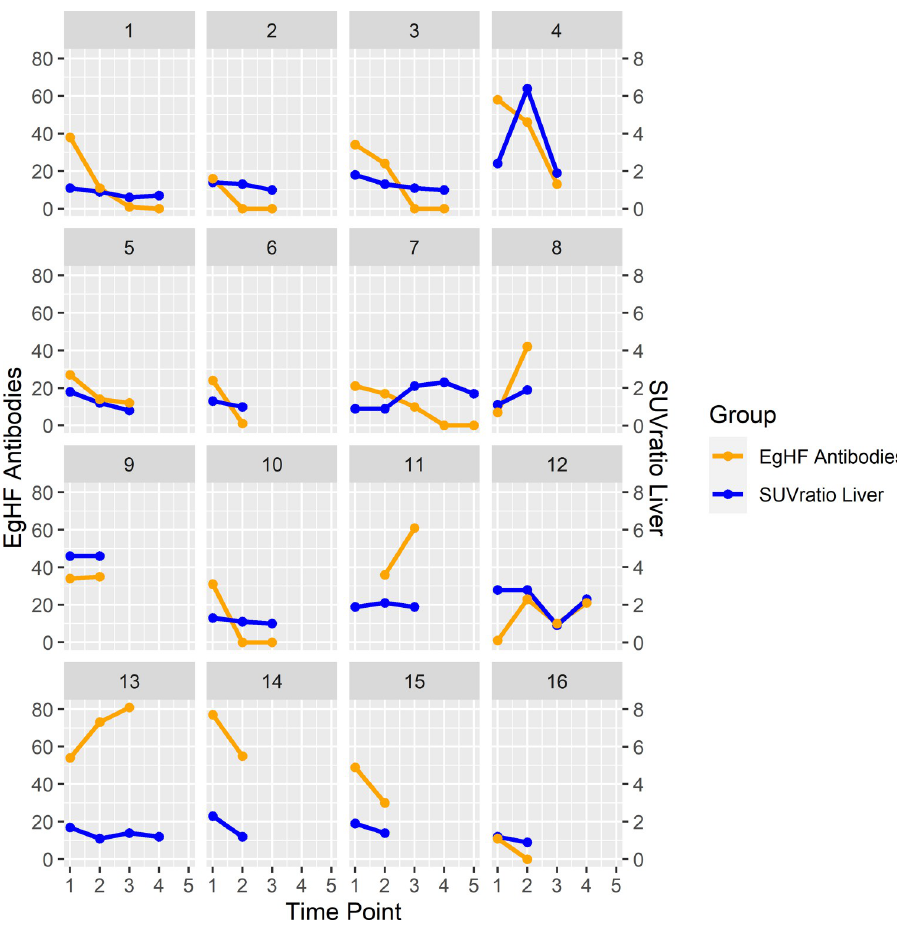
Fig 3. The graphs display the courses of EgHF antibody units and SUVratio liver over time in all 16 included patients with alveolar